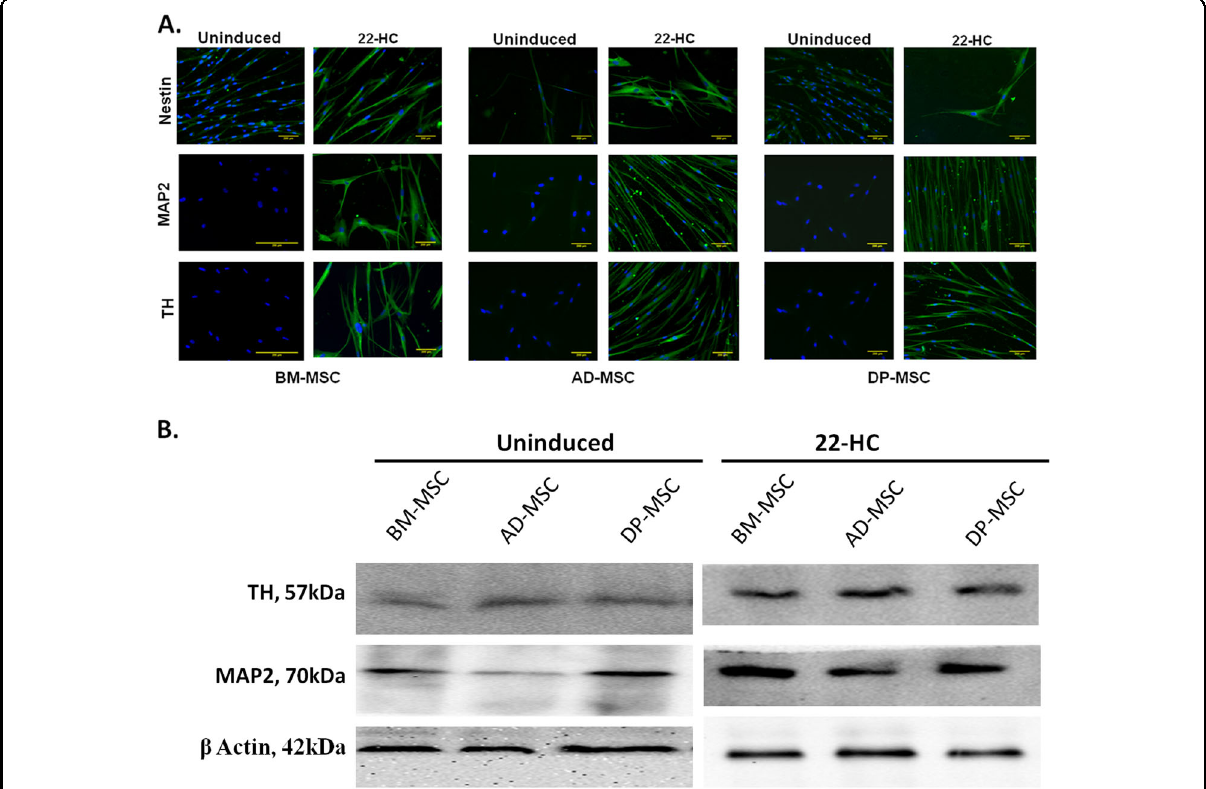
Fig. 3 Expression of neuronal cell-associated proteins in differentiated hMSCs. A Immuno fl orescence assay showing expression of nestin, MAP2 and TH protein expression in hMSCs pre-differentiation and post-differentiation into DAergic neuronal cells. B Immunoblotting assay for expression of neuronal and DA neuronal cells associated proteins (MAP2 and TH) in uninduced and differentiated